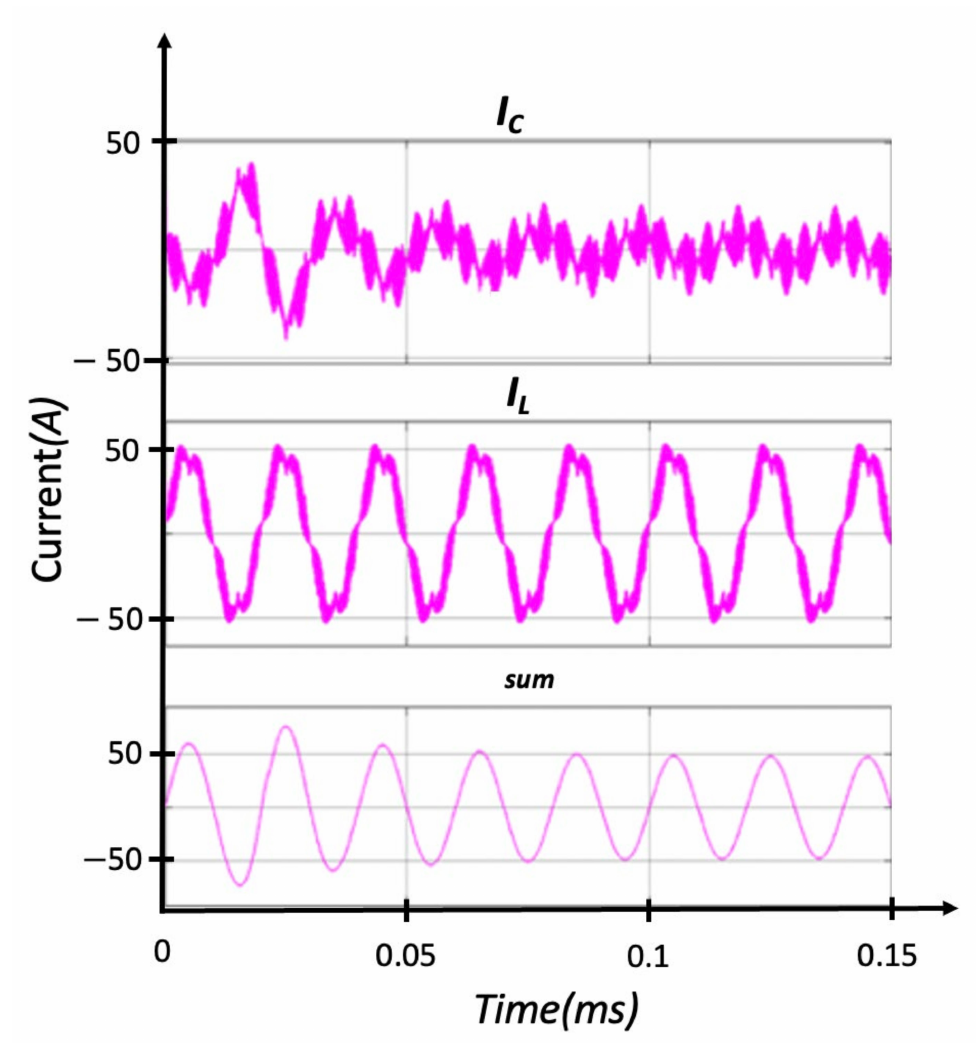
Figure 10. High-frequency error